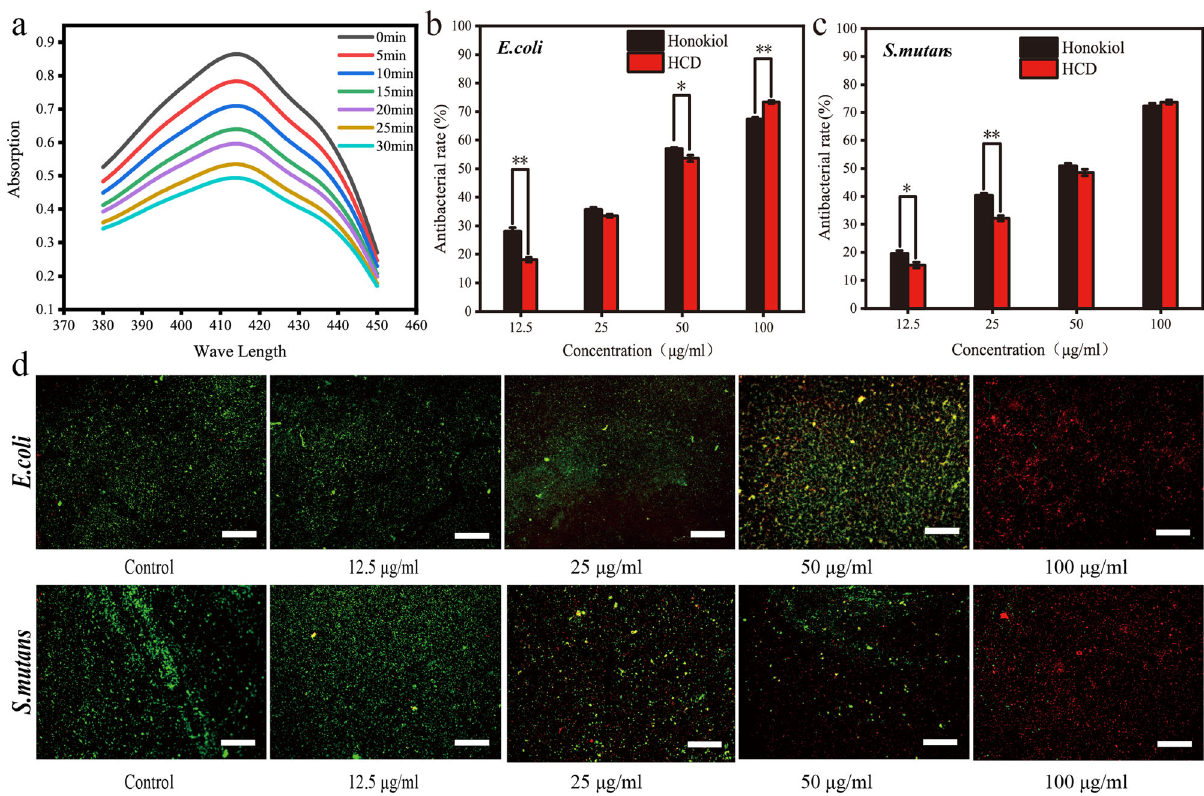
Fig. 3 The antibacterial properties of HCDs. a The UV absorption spectrum between 350 nm and 500 nm was measured for HCDs by a UV absorption spectrometer under daylight for 0, 5, 10, 15, 20, 25, and 30 min, respectively. b , c The antibacterial rate of Honokiol and HCDs against E. coli ( b ) and S. mutans ( c ) as a function of concentration